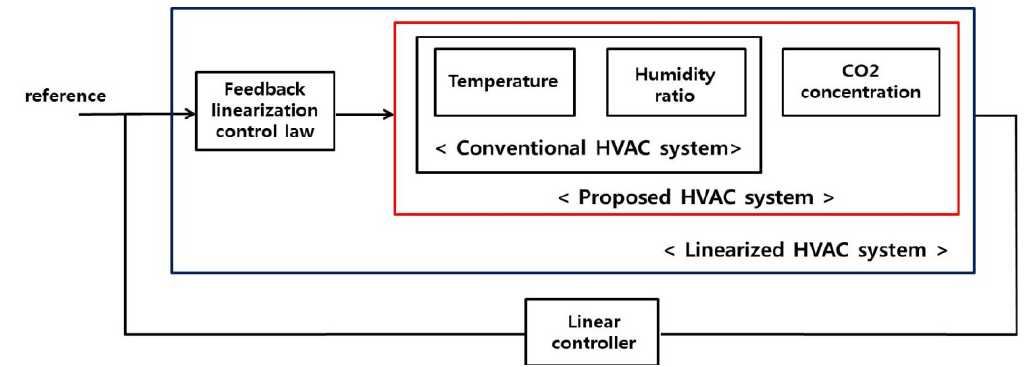
Figure 2. Overall block diagram for controlling the proposed HVAC